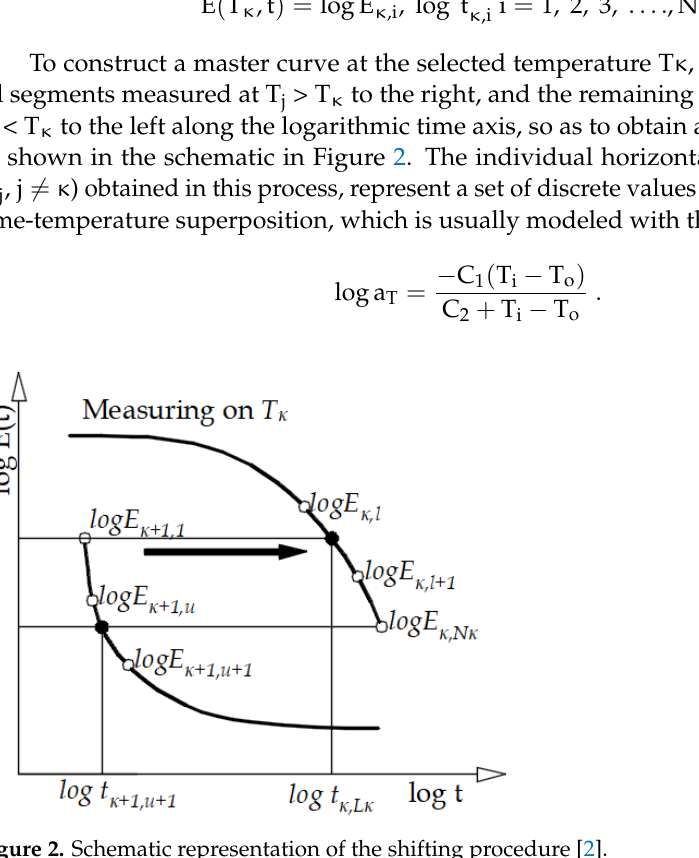
Figure 2. Schematic representation of the shifting procedure [2].